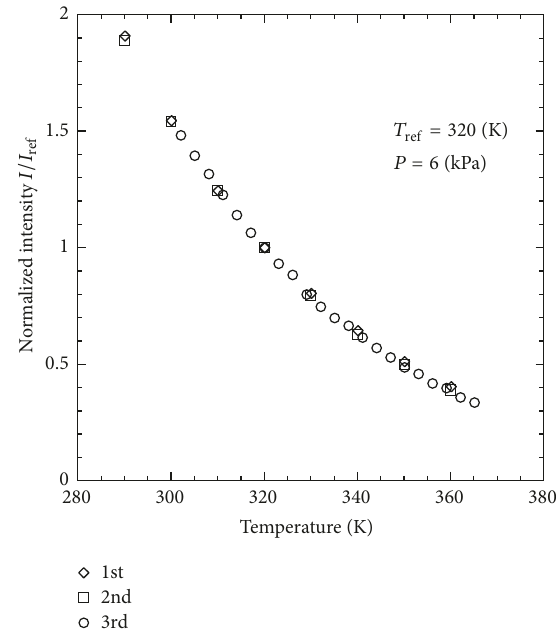
Figure 7: Temperature-sensitivity of the temperature sensitive paint in a vacuum